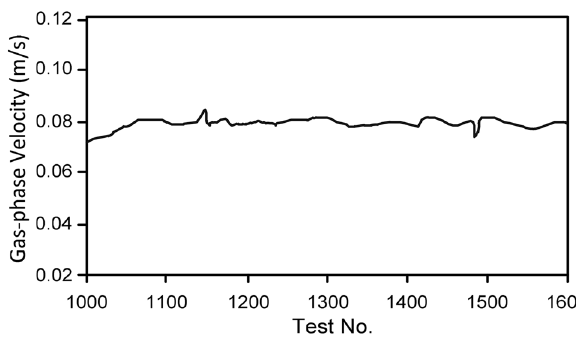
Fig. 6 Gas-phase velocity when standard gas output is 2.976 m